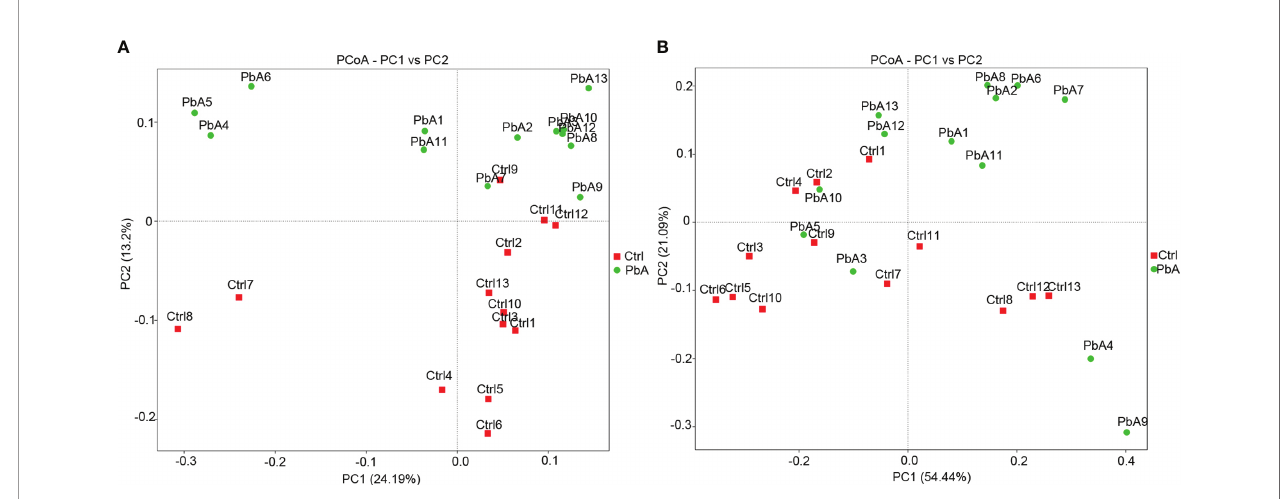
FIGURE 4 | Principal coordinates analysis (PCoA) based on unweighted (A) and weighted (B) UniFrac distance matrixes of fecal samples of C57BL/6 mice during infection. The fecal bacterial community components of both Ctrl- and PbA- infected mice are represented. Sample names are as described in Table 1